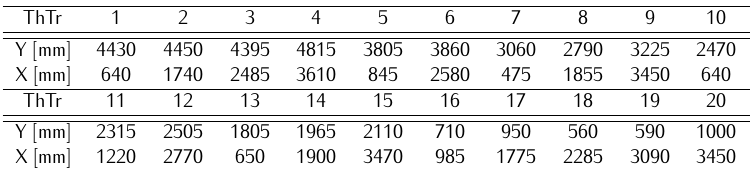
Table 6. Numerical thermocouples trees locations, X-axis and Y-axis coordinates.